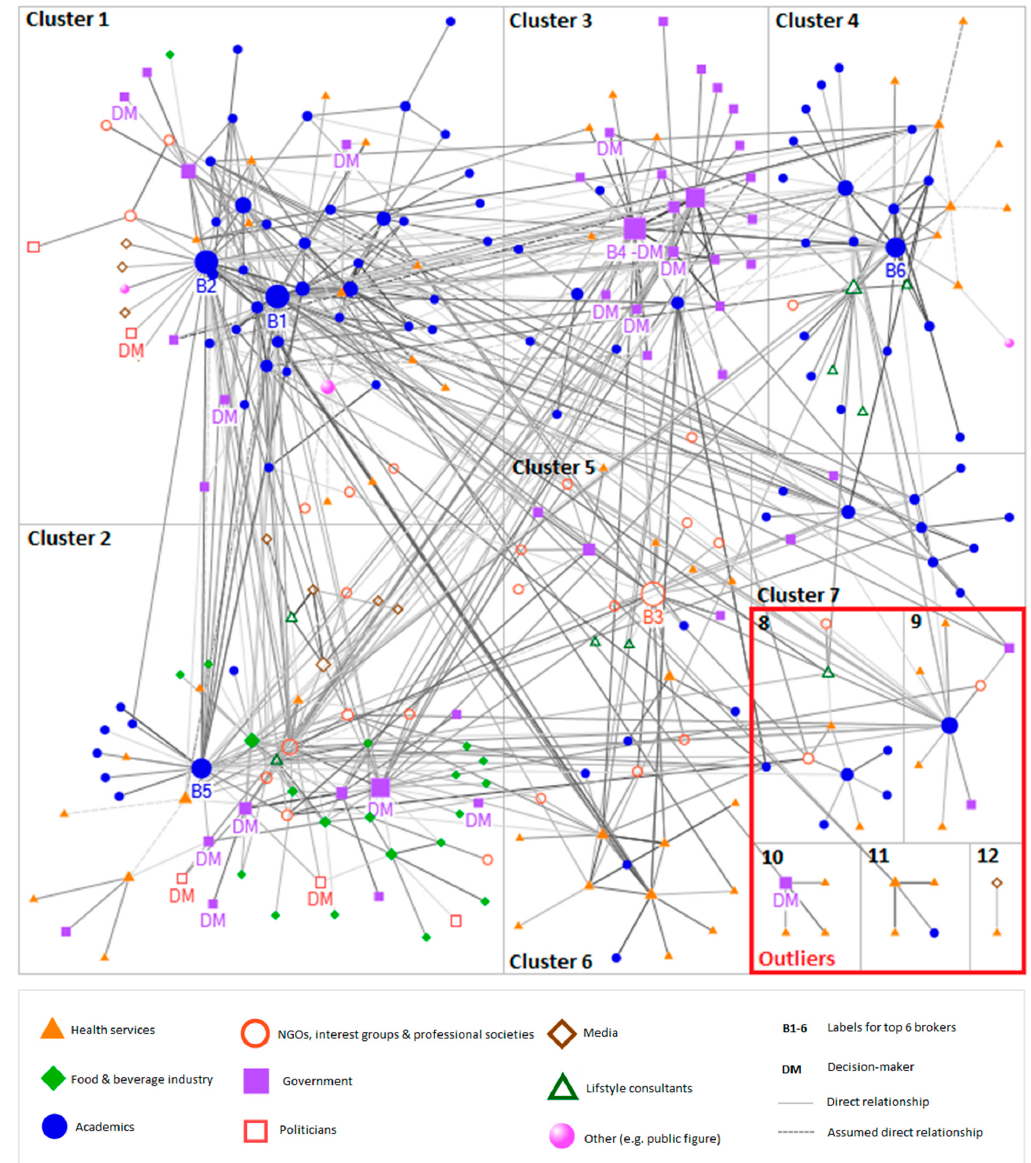
Figure 8. Cluster analysis of the New Zealand Diabetes and Obesity network, distinguishing 12 subgroups of individuals who closely interact with one